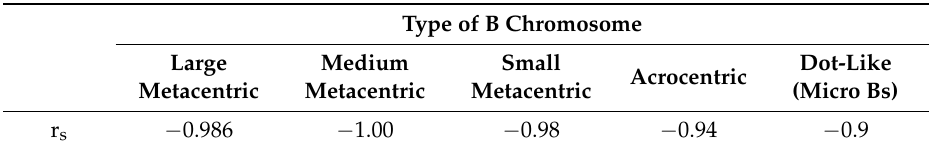
Figure 5. Ratio of A. peninsulae karyotypes with a certain number of micro B chromosomes across studied populations.